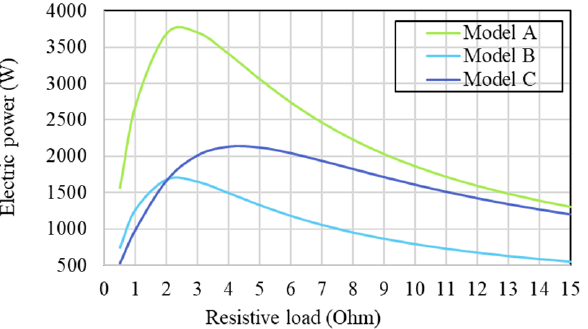
Figure 15. Electrical power versus resistive load for constant speed of 5 m/s, (FEA by MagNet software). Figure 16 represents the comparison of the velocity of three models versus piston displacement. Model ‘A’ has the lowest peak velocity of 4.9 m/s for the heaviest piston mass. Model ‘C’ has a peak velocity of 7.1 m/s and model ‘B’ has the highest value of 7.9 m/s. This could reflect the reality that model ‘B’ has the highest frequency while three models have a nearly equal stroke. However, the position of the peak velocity is not in the center of the stroke and the velocity versus displacement curve is not a standard ellipse, which is related to the reality that the balanced position of the piston is not in the center due to load force, friction, and valve timing. In more detail, due to the valve control mechanism, the gas force is relatively large at the beginning of the stroke and gradually decreases to the value of the sum of other forces in different directions. This is the force balance point where the piston exceeds the stroke center, and the velocity reaches a peak value.